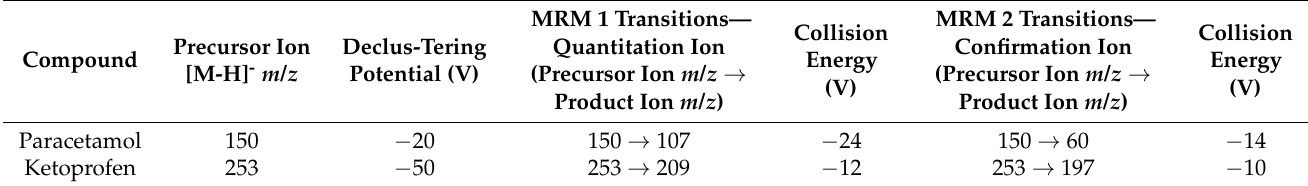
Table 1. MS/MS parameters for the acquisition of